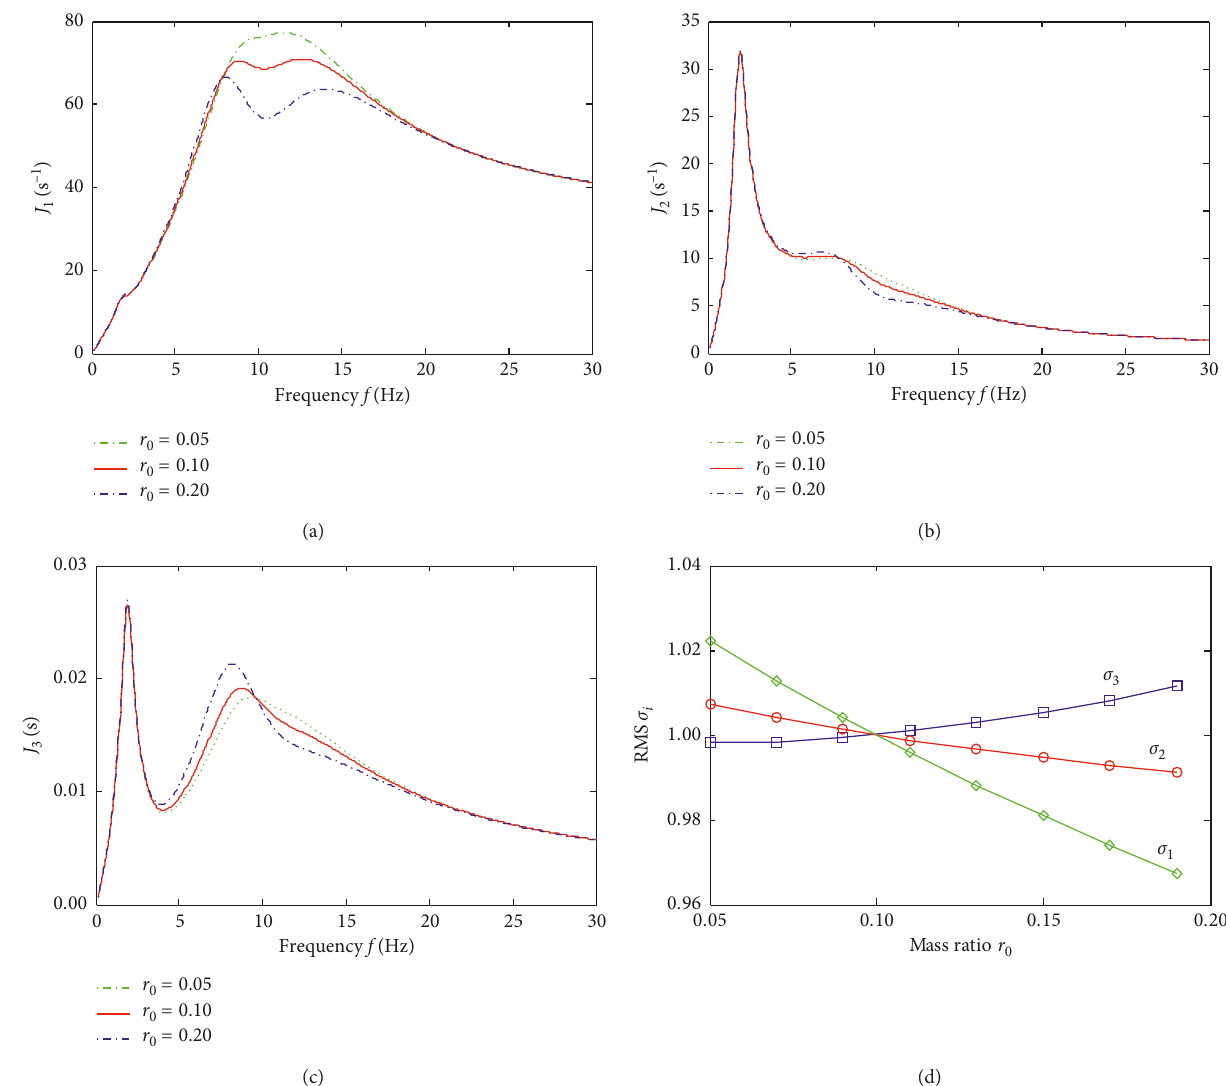
Figure 5: Influences of r frequency characteristics J and σ versus r 3 0